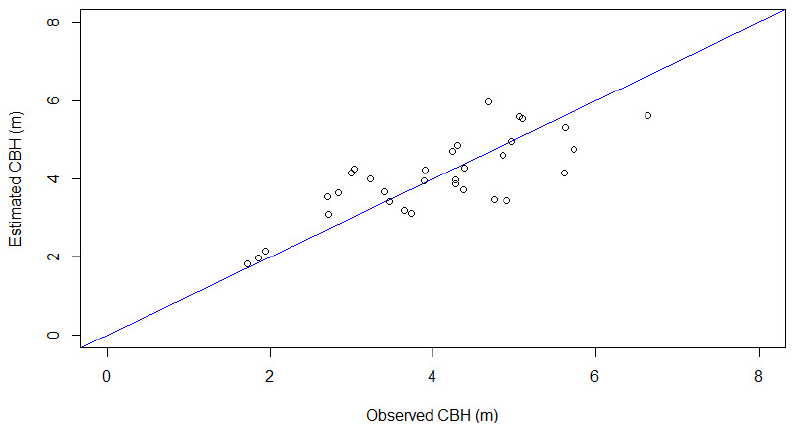
Figure 9. Comparison of the field measured and the predicted CBH values ( R 2 = 0.61).